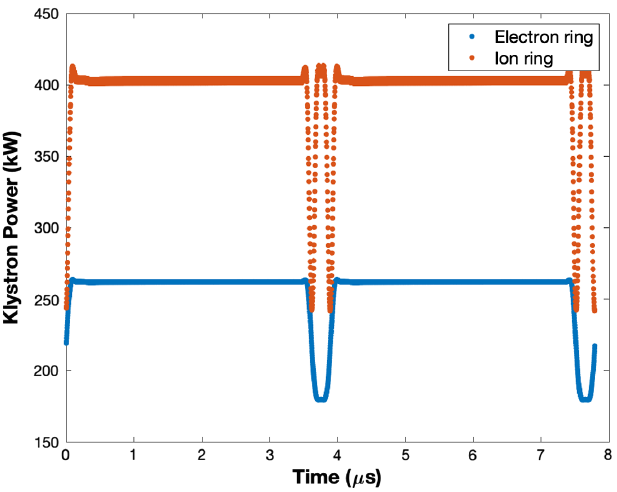
FIG. 11. Klystron power with